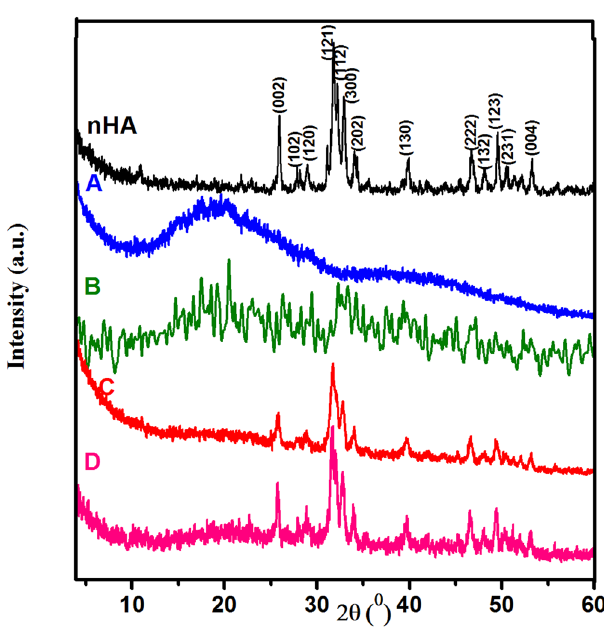
Figure 1. XRD patterns for nHA and Dex-CS/nHA scaffolds with different concentrations of HA (A) 0, (B) 20, (C) 30 and (D) 40 Wt%.